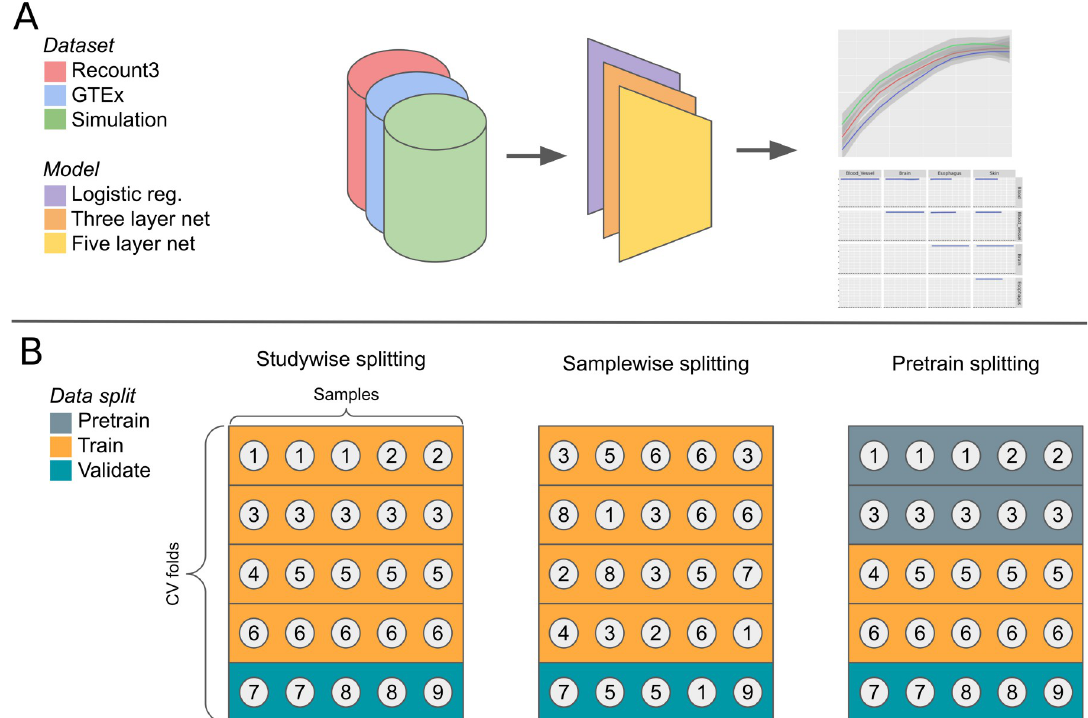
Fig 1. Schematic of the model analysis workflow. We evaluate three models on multiple classification problems in three datasets (A). We stratify the samples into cross-validation folds based on their study (in Recount3) or donor (in GTEx). We also evaluate the effects of sample-wise splitting and pretraining (B). Each circle in the figure represents a sample, which is numbered according to its study.